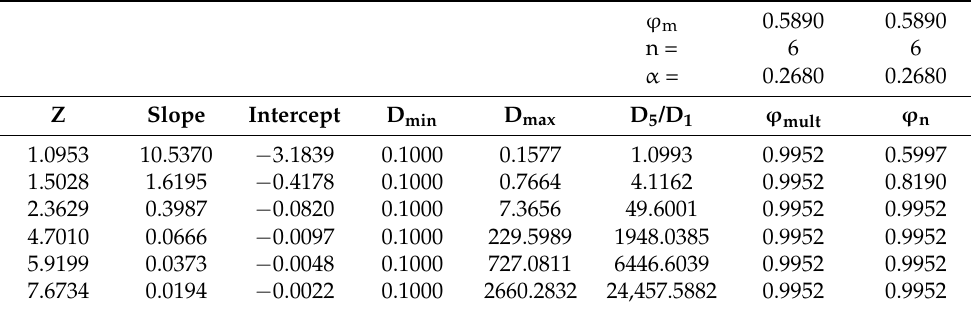
Figure 8. Five calculated optimum straight line distributions with six particles and five different ratios between particles, Z values. Table 6. Summary of straight lines for six optimum particle distributions with different Z values but the same starting particle